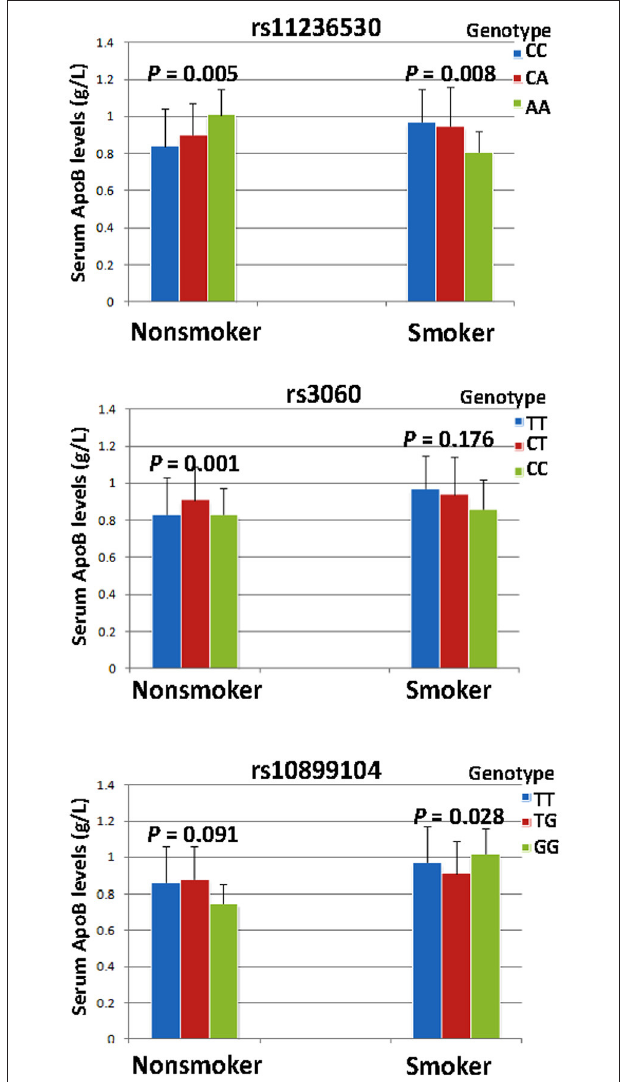
FIGURE 2 | The rs11236530-smoking, rs3060-smoking and rs10899104-smoking interactions on serum ApoB concentrations. P I ≤